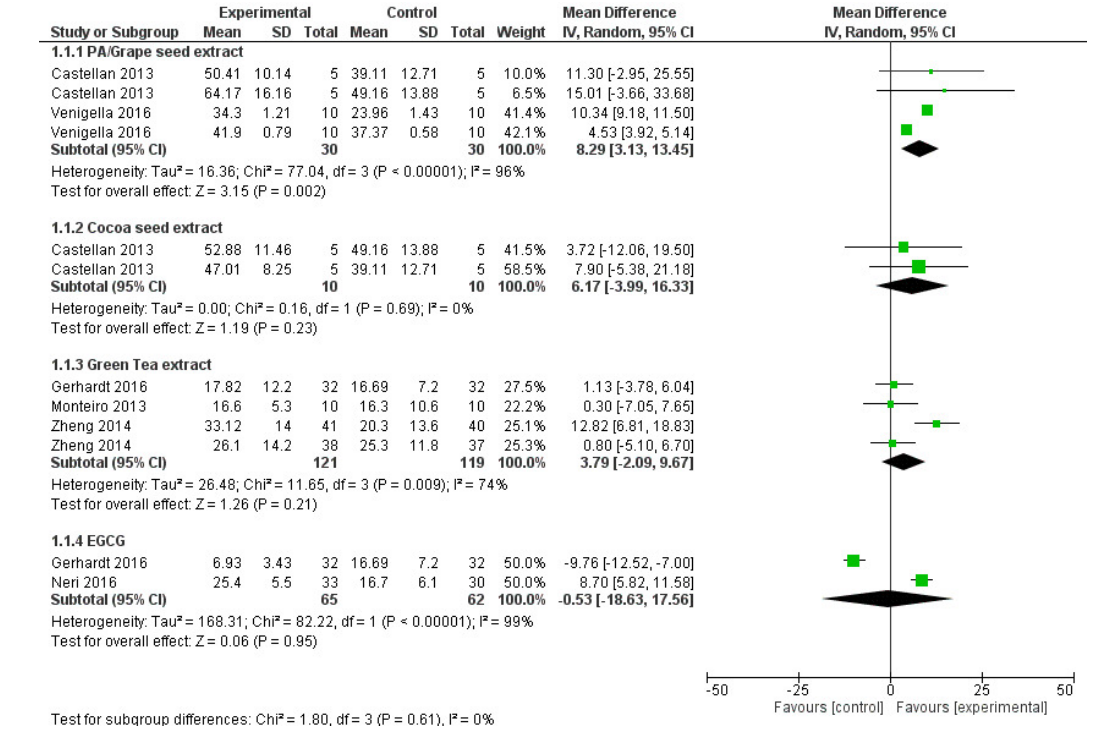
Figure 3. Classification diagram of MOF-derived catalysts for air cathode in Zn-air battery. Figure 3. Forest plot analysis of studies with 6–9 months of ageing (<1 year). Figure 3. Forest plot analysis of studies with 6–9 months of ageing (<1 year).